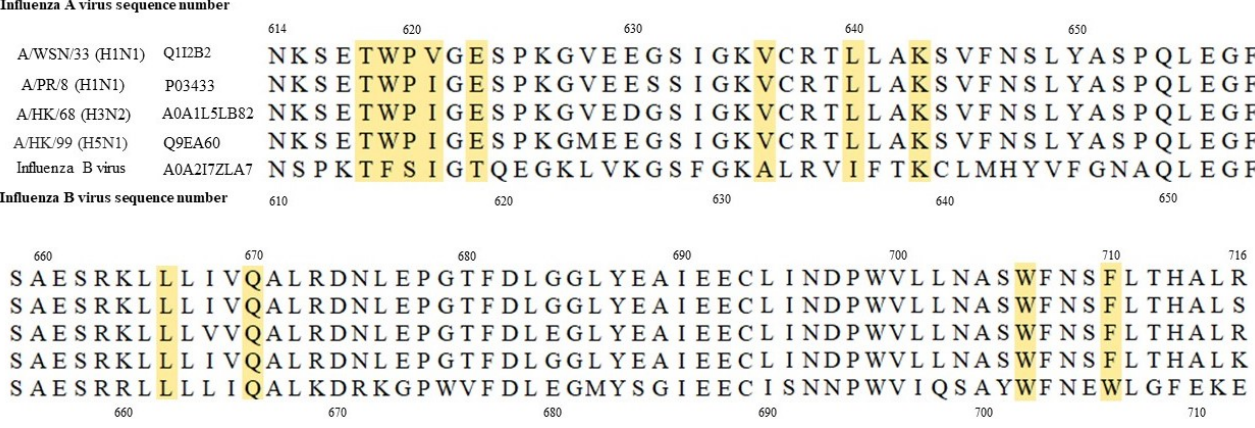
Figure 3. Amino acid sequence alignment of influenza virus PA protein (residues 614–716 for influenza A virus and residues 610–712 for influenza B virus) including strain A/WSN/33 (H1N1, Uniprot accession number Q1I2B2), strain A/PR/8 (H1N1, Uniprot accession number P03433), strain A/HK/68 (H3N2, Uniprot accession number A0A1L5LB82), strain A/HK/99 (H5N1, Uniprot accession number Q9EA60) and influenza B virus (Uniprot accession number A0A2I7ZLA7). Residues that are required for PA–PB1 interface are labelled with